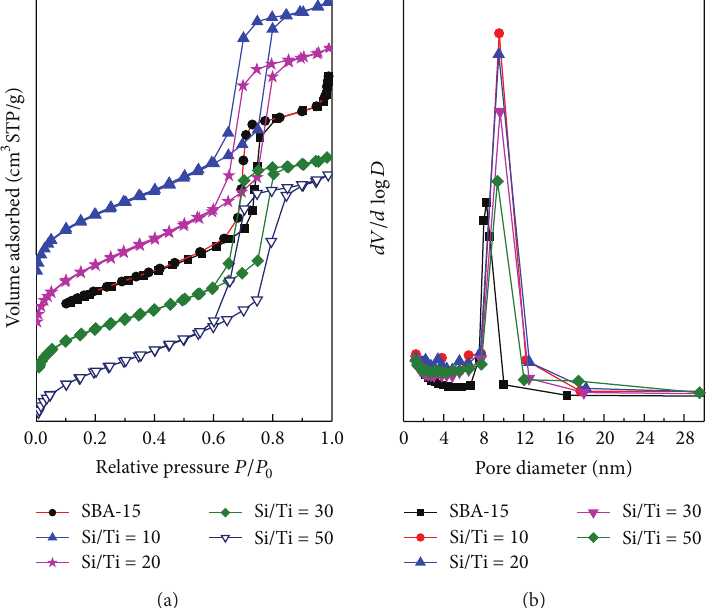
Figure 5: Nitrogen adsorption-desorption isotherms (a) and pore size distribution curve of different titanium content of Ti-SBA-15